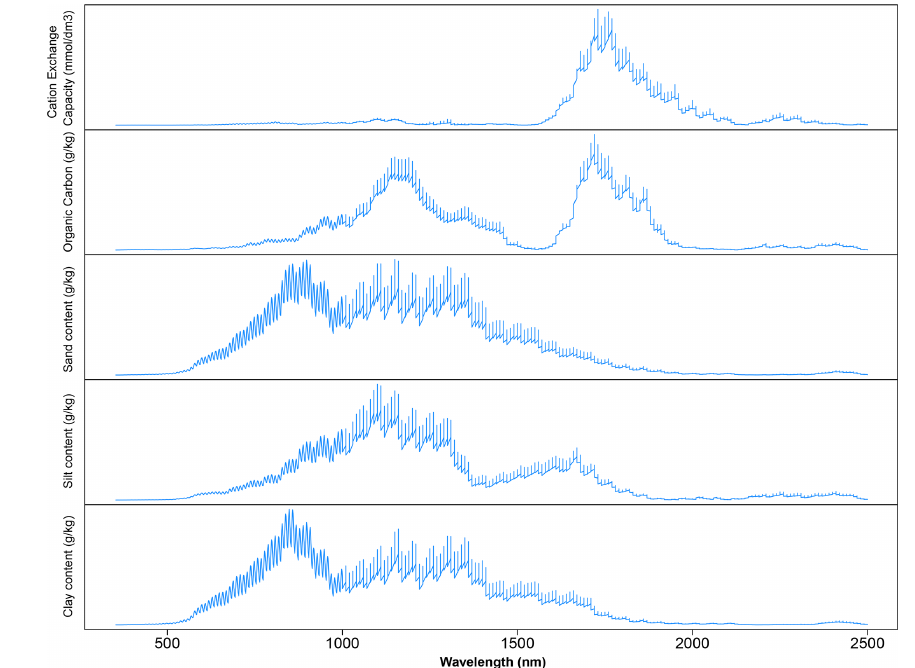
Figure 8. Sensitivity analysis of the visible, near and shortwave infrared (VIS–NIR–SWIR) spectra in predicting various soil properties using the convolutional neural network (CNN) model. The graph depicts the sensitivity index (calculated from Eq. 2) for different soil properties as a function of